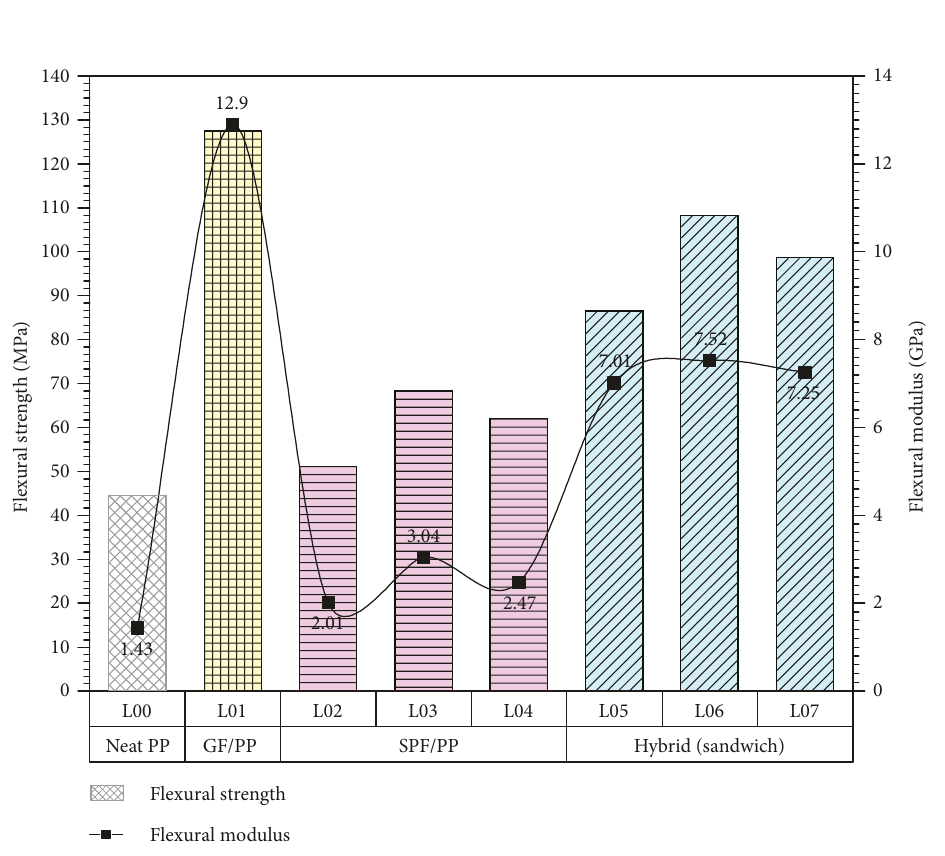
Figure 5: Flexural properties of the hybrid and nonhybrid